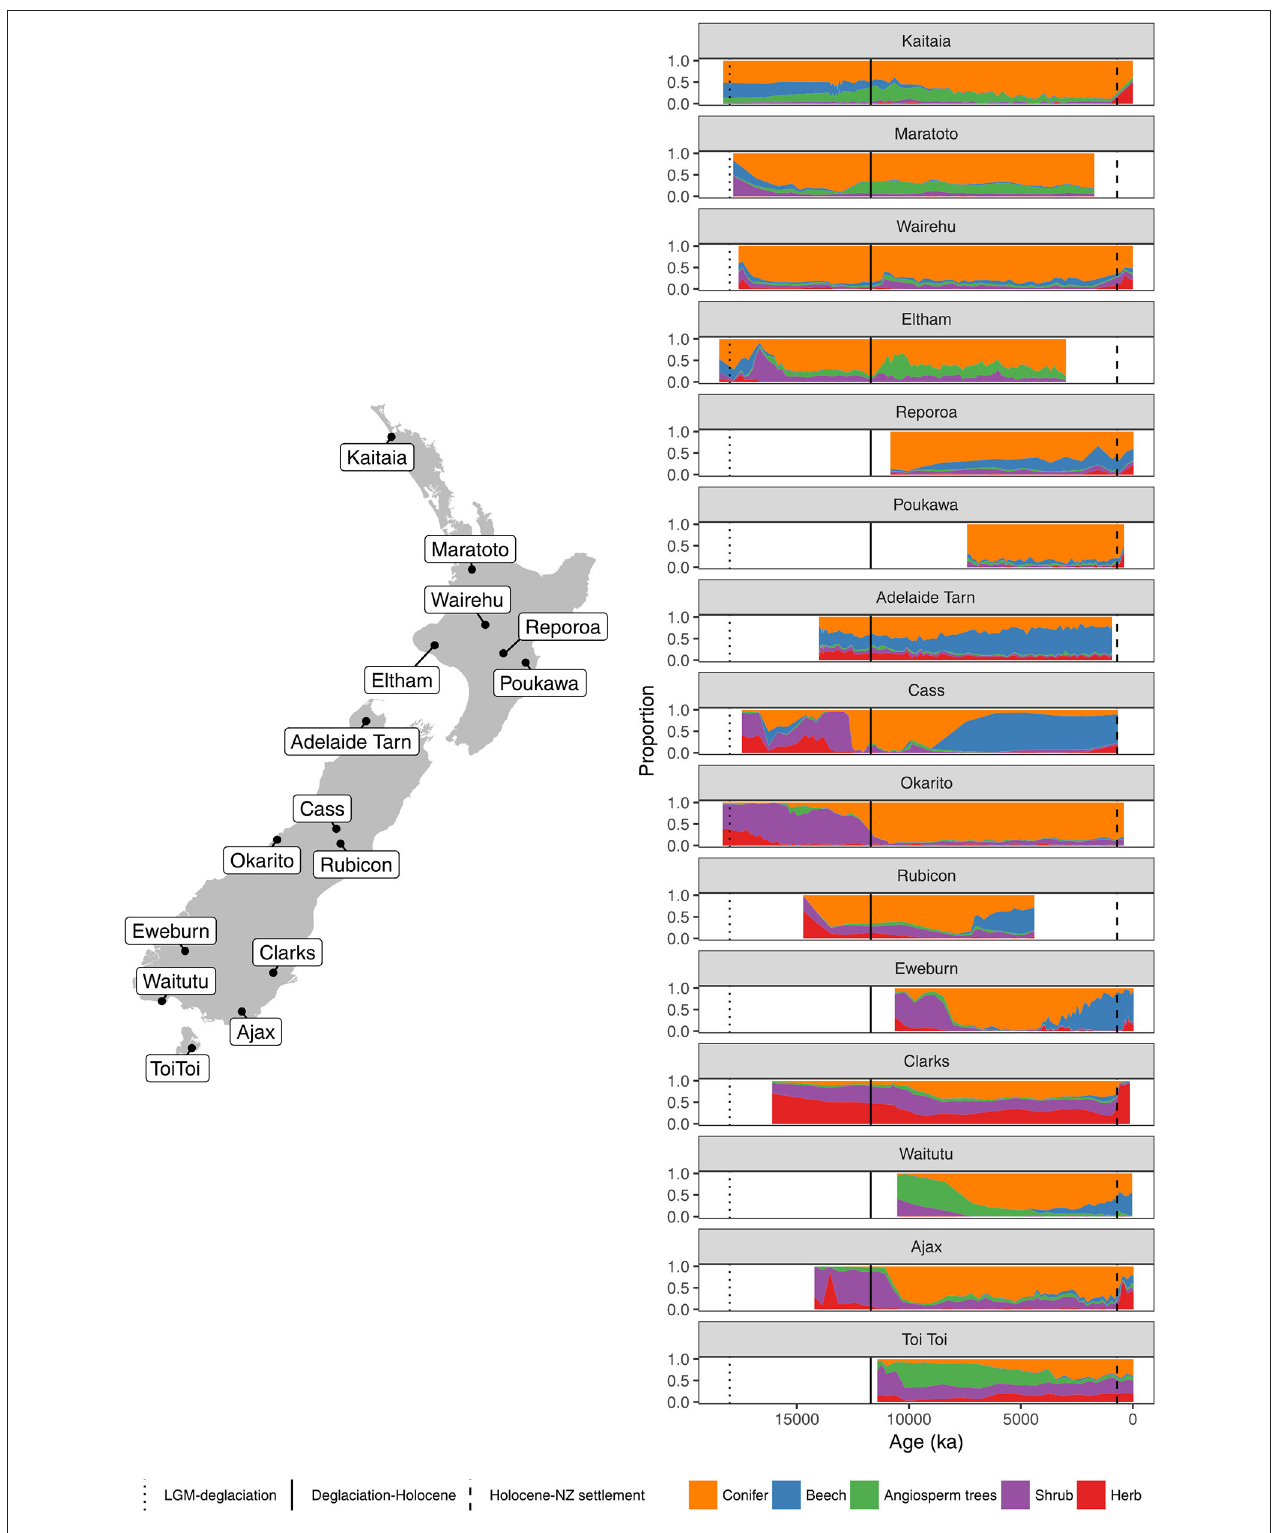
FIGURE 4 | Summary percentage pollen diagrams (sum: all terrestrial types excluding ferns, lycopods and wetland forbs, rushes, and sedges) and site locations.